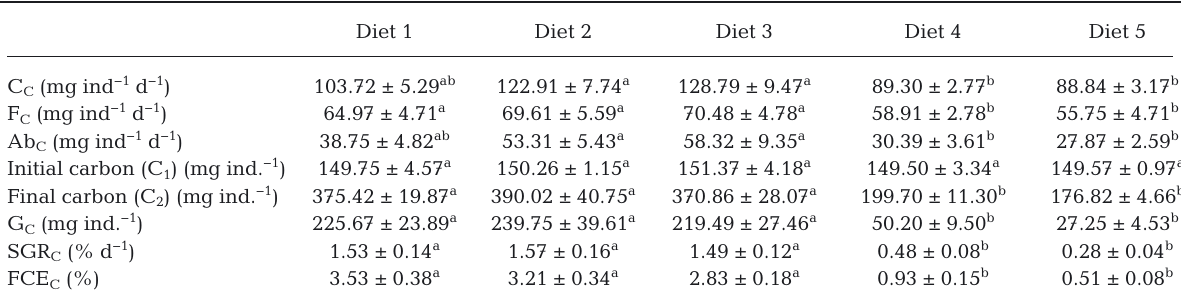
Table 2. Carbon feeding budget parameters of sea cucumbers in 5 diet treatments (mean ± SD, n = 4): carbon consumption weight (Cc), carbon in feces (F C ), carbon absorbed by sea cucumber (Ab C ), carbon used for growth (G C ), where Ab C = C C − F C and G C = C 1 − C 2 (C 1 , C 2 are initial and final carbon weight); also shown are carbon specific growth rate (SGR C ) and food carbon conversion efficiency (FCE C ), Values with different letters in the same row are significantly different from each other (ANOVA and Tukey’s multi-comparison; p <